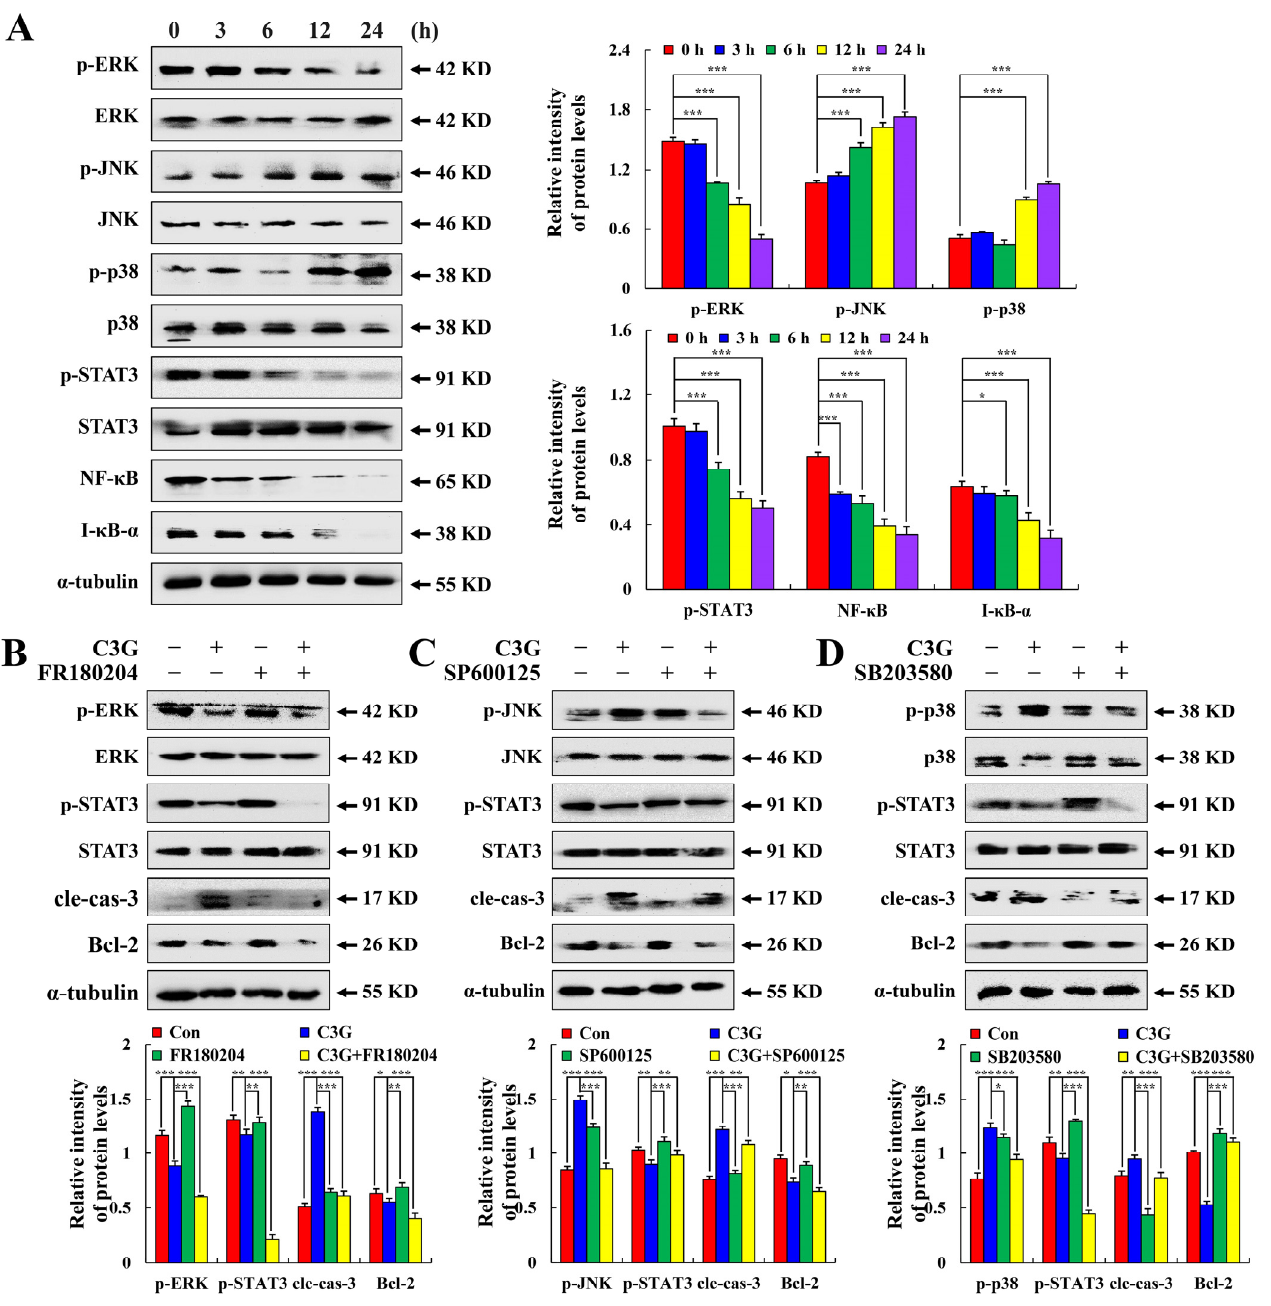
Figure 4. Effects of C3G on the MAPK signaling pathway in MKN-45 cells. ( A ) Western blot analysis of MAPK/STAT3/NF- κ B pathway-related protein expression. ( B ) Expression levels of proteins treated with C3G and ERK inhibitors. ( C ) Expression levels of proteins treated with C3G and JNK inhibitors. ( D ) Expression levels of proteins of treated with C3G and p38 inhibitors. α -tubulin served as an internal reference (* p ≤ 0.05, ** p ≤ 0.01, *** p ≤ 0.001 vs. 0 h or C3G + MAPK inhibitor).